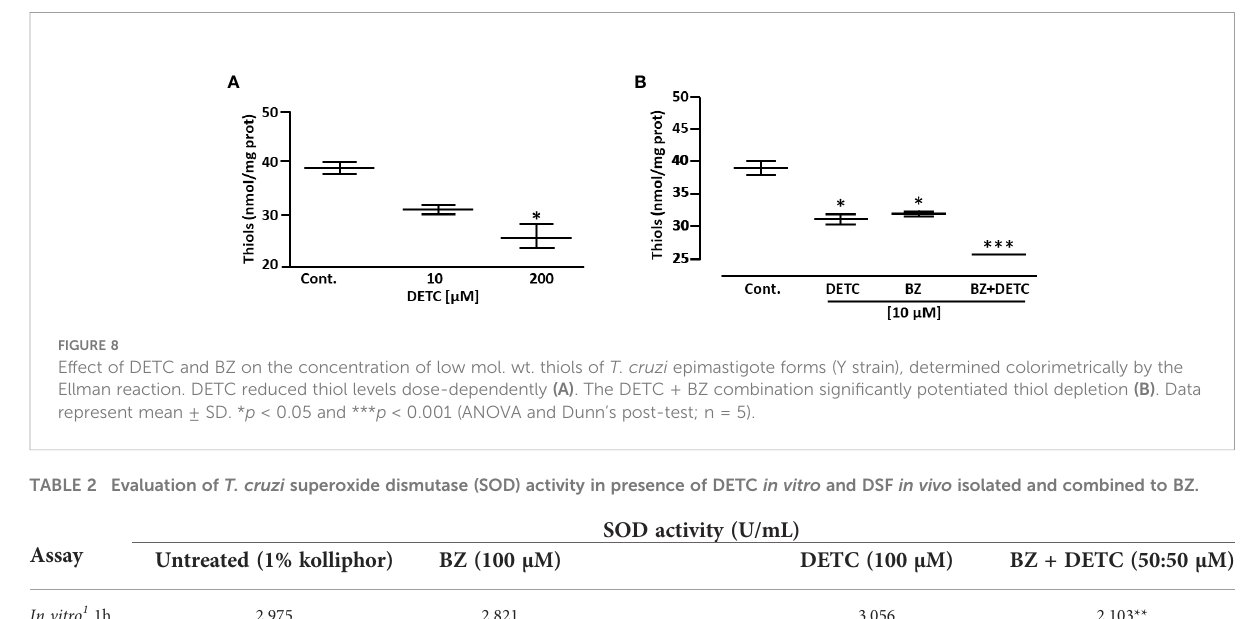
SOD activity (U/mL)